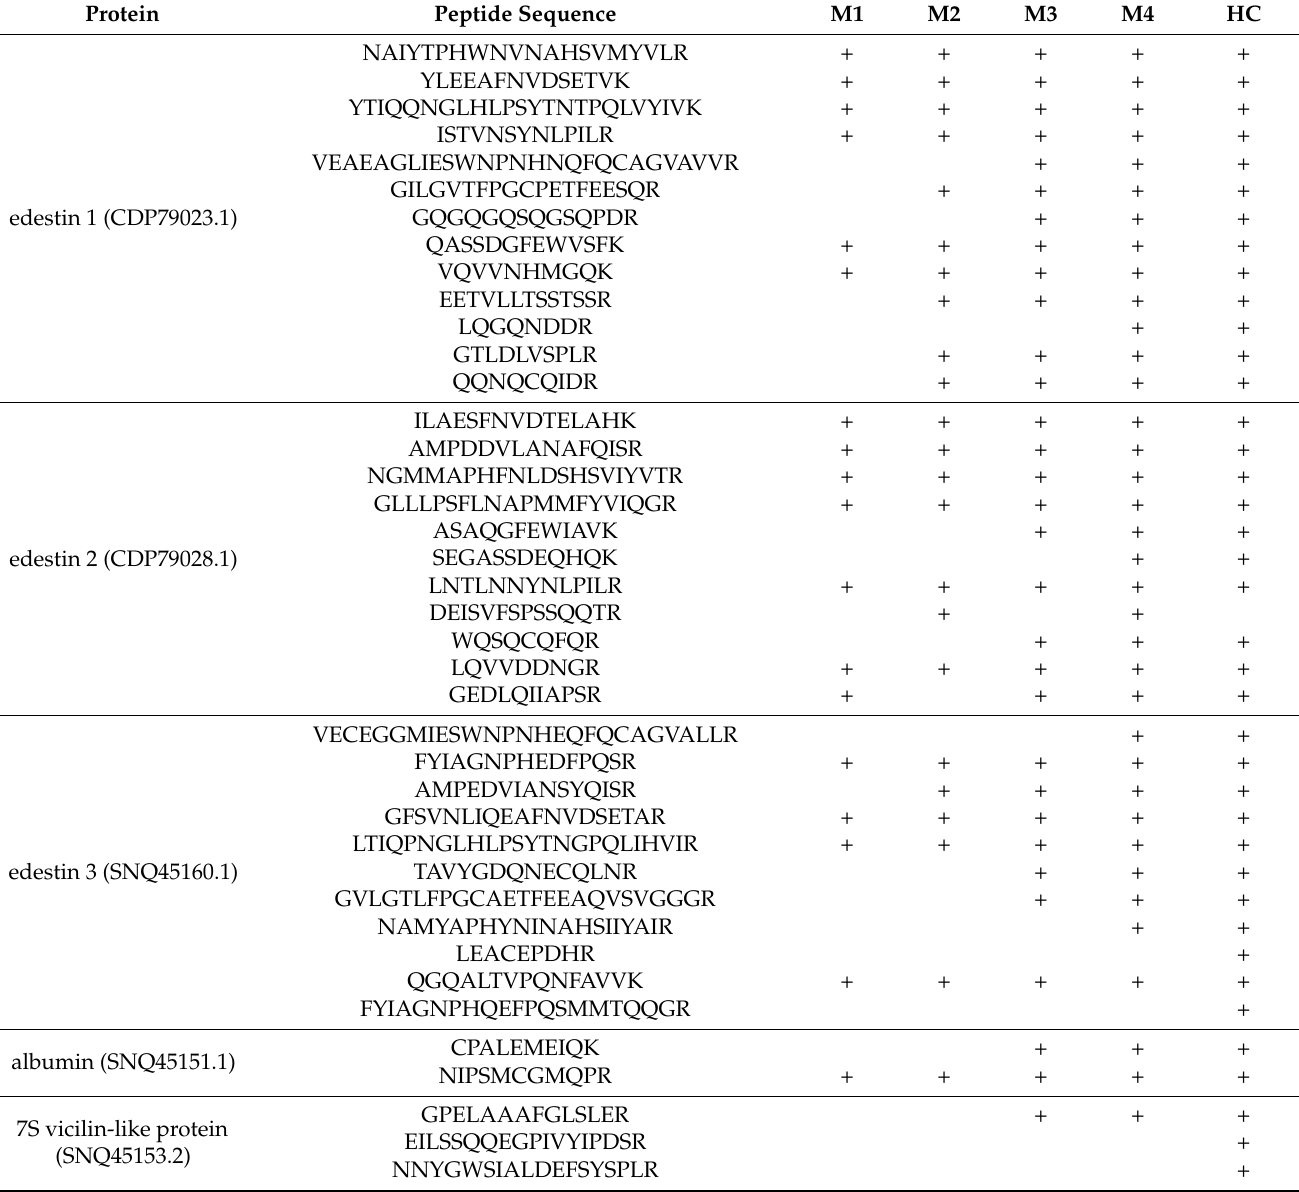
to detect the addition of hemp at low concentrations of below 1%. The LOD for edestin subunits and albumin was 0.9% ( w / w ), whereas for 7S vicilin-like protein it was 4.2% ( w / w ). Several sequences of unique peptides were detected in all meatball variants, e.g., the peptides VQVVNHMGQK and GFSVNLIQEAFNVDSETAR originating from edestin 1 and edestin 3, respectively (Table 3). This proves that the method has high discriminating power for authentication purposes but identification of the ingredients should be based on the most abundant proteins and heat-stable peptides of the tested raw material, i.e., edestin subunits in the case of hemp seeds. Table 3. Hemp-seed-specific peptides detected in hemp cake and cooked